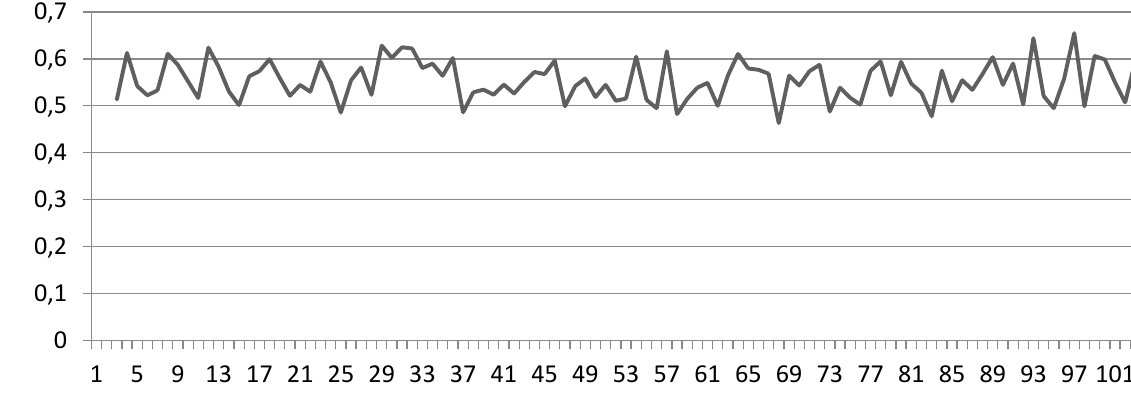
Figure 6. Majan College asset turnover ratio – Monte Carlo simulation results